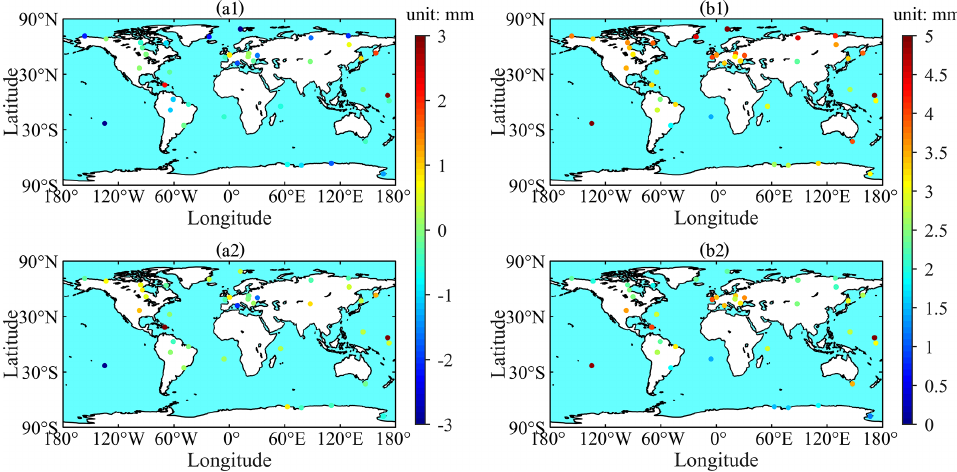
Figure 13. Bias (a1) and RMSE (b1) of PWV-GPT3 and bias (a2) and RMSE (b2) of PWV-GZHD in the 154d period from 1 January to 30 June 2020 at each of the 41 global IGS stations (reference: